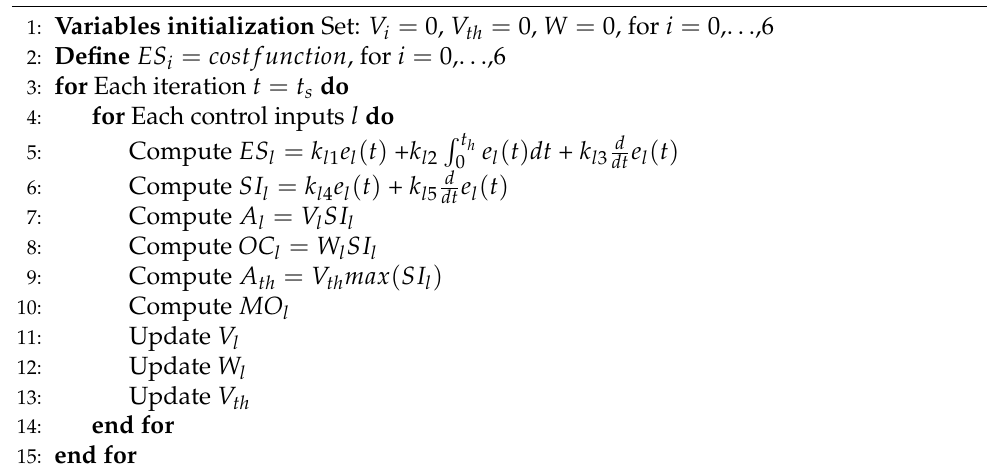
Algorithm 1 The BELBIC-inspired algorithm for UAV